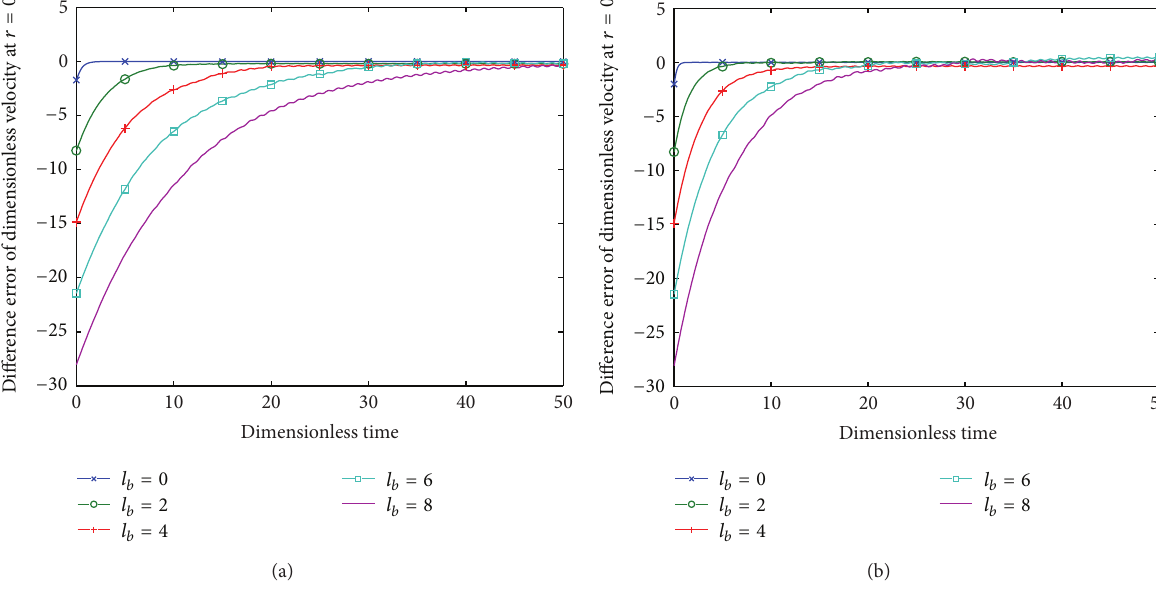
Figure 5: Diagrams showing the convergence of numerical solutions for different slip parameters and artery radii: (a) 𝑟 = 0.15 cm; (b) 𝑟 = 0.50